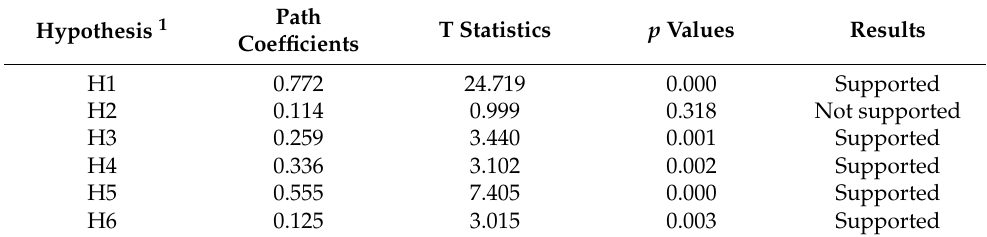
Table 5. PLS-SEM results: size and significance of path